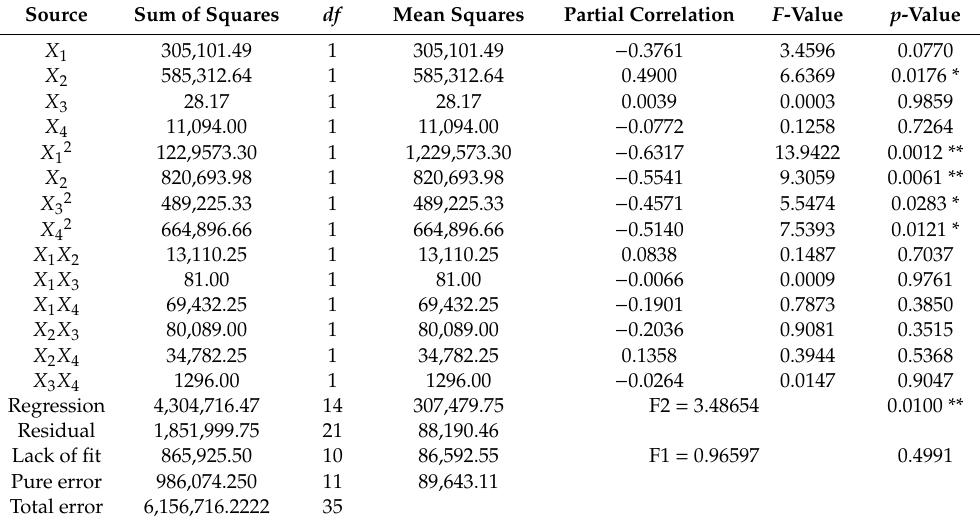
Table 3. Analysis of variance (ANOVA) of fiber yield of